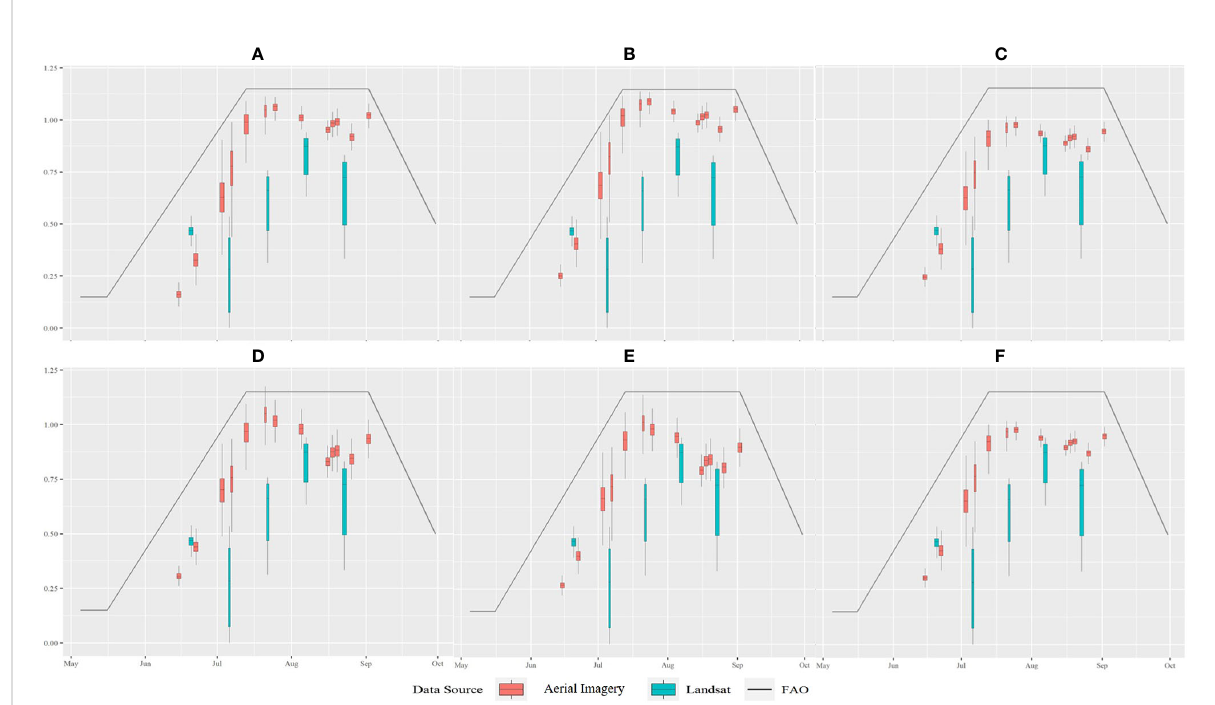
FIGURE 2 Boxplots of crop coef fi cients at Field A from Landsat and Aerial Imaging. Crop coef fi cients were estimated from equations developed by (A) Kamble et al. (2013), (B) Bausch and Neale (1987), (C) Bausch and Neale (1987), (D) Bausch (1993), (E) Campos et al. (2017), and (F) Neale et al.,